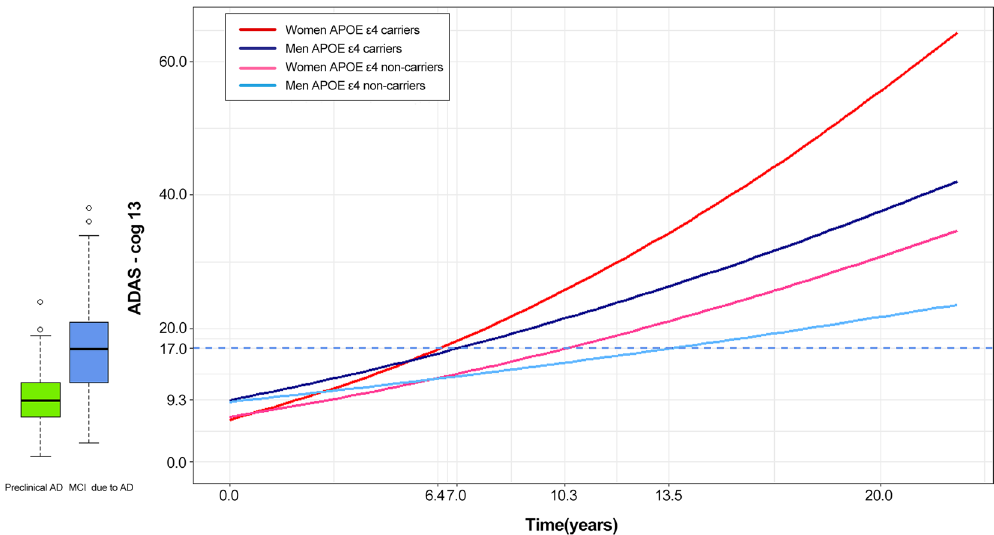
Figure 4. Sex and APOE ε4 effects on disease progression . We analysed differences in cognitive decline by sex and APOE ε4 status. Different-coloured lines indicate women APOE ε4 carriers (red), women APOE ε4 non- carriers (pink), men APOE ε4 carriers (dark blue) or men APOE ε4 non-carriers (light blue). The box plot shows the median value of ADAS-cog 13 was 9.3 for preclinical AD and 17.0 for MCI due to AD. The time differences between APOE ε4 carriers and non-carriers at baseline median ADAS-cog 13 in the MCI due to AD cohort (17.0 points) were 3.9 years for women (10.3 years (APOE ε4 non-carriers)—6.4 years (APOE ε4 carriers)) and 6.5 years for men (13.5 years (APOE ε4 non-carriers)—7.0 years (APOE ε4 carriers)). The estimated equation for each sex and APOE ε4 combination is as follows: ADAS Cog-13 = (2.6131 + 0.0203 × month) 2 – 0.5 for women APOE ε4 carriers, = (2.6842 + 0.0121 × month) 2 – 0.5 for women APOE ε4 non- carriers, = (3.1198 + 0.0127 × month) 2 – 0.5 for men APOE ε4 carriers, = (3.0806 + 0.0068 × month) 2 – 0.5 for